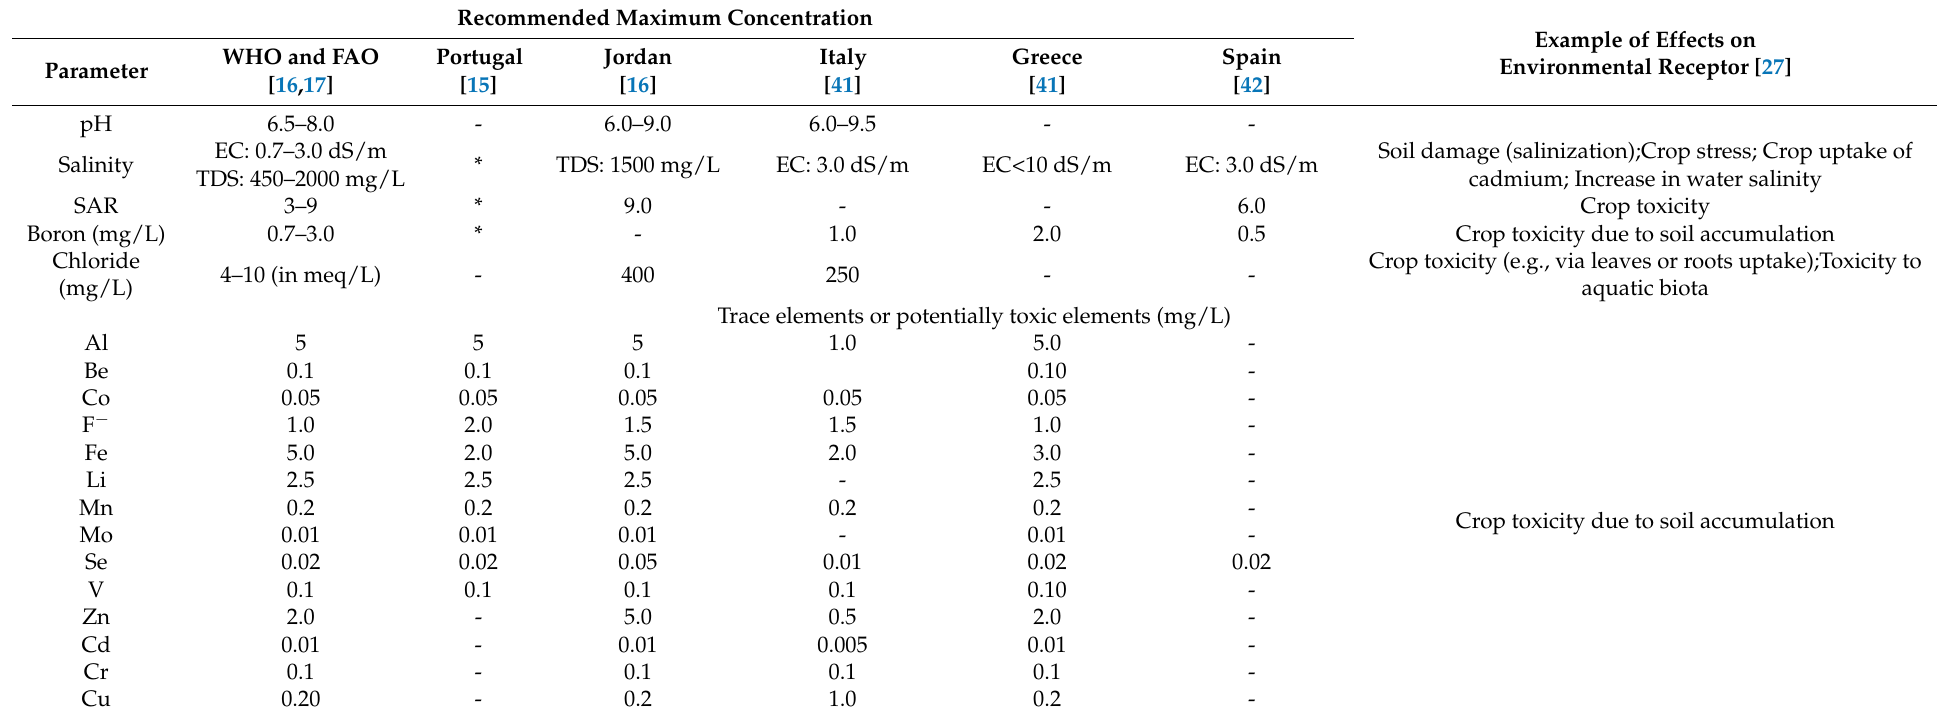
Table 5. Maximum recommended concentrations for some parameters, independently of the reclaimed water